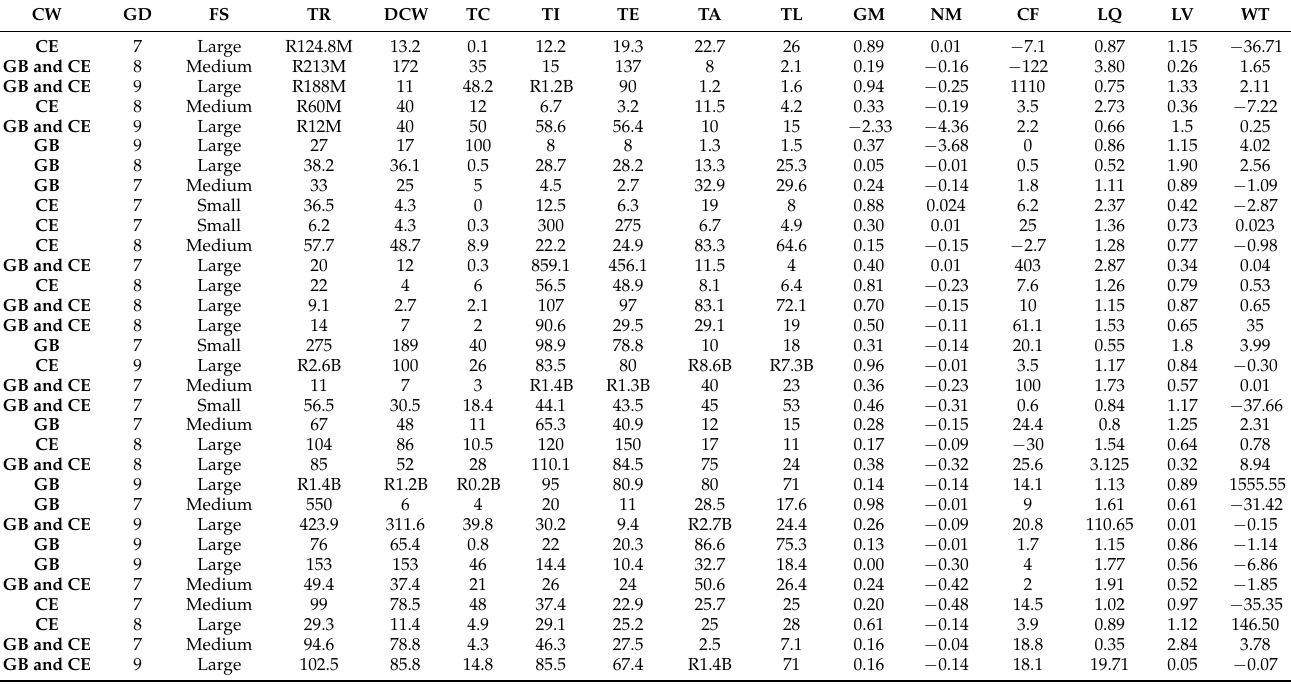
Table 4. Analysis of the financial performance of construction